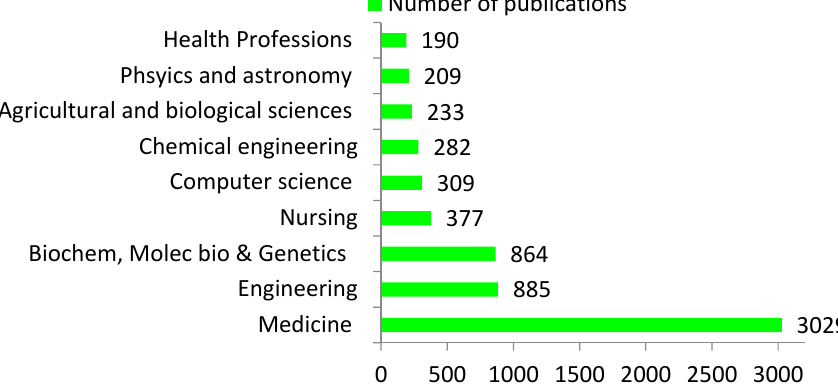
Figure 9. Bioimpedance publication distribution according to the subject area.